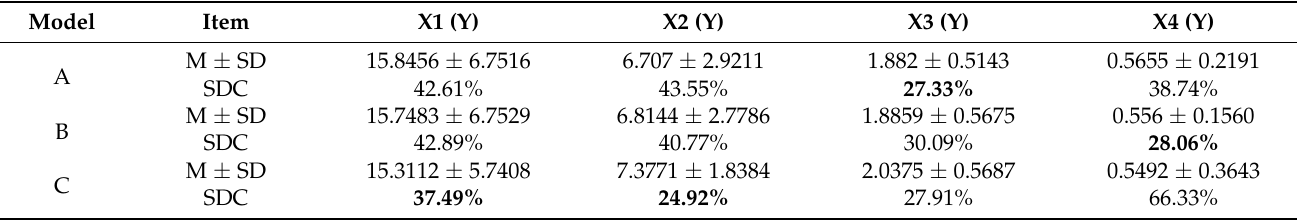
Table 7. Statistical table of the mean (M), standard deviation (SD), and standard deviation coefficients (SDC) of percentage distributions along the Y -axis on coordinates X1, X2, X3, and X4: (A) single threshing gap of 15 mm; (B) single threshing gap of 10 mm; (C) multi-threshing gaps of 10 mm and 15